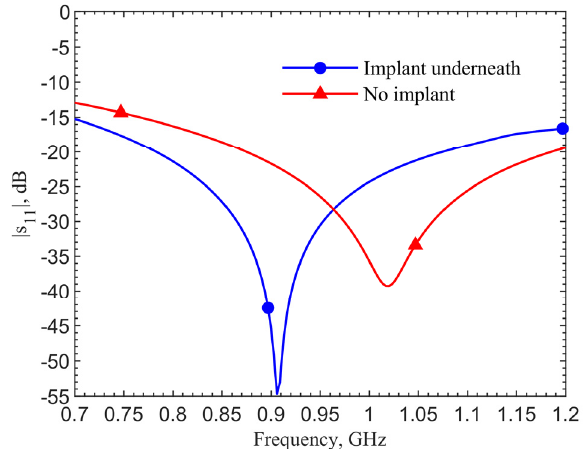
Figure 12. Comparison of s 11 magnitude between the cases with and without implant underneath the skin.